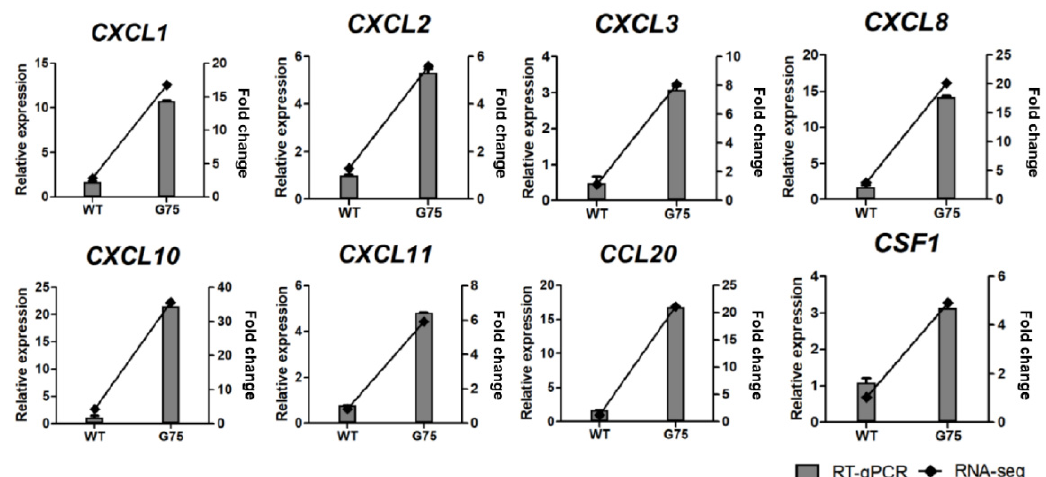
Figure 9. Real ‐ time quantitative PCR validation of RNA ‐ seq data for selected genes associated with Figure 9. Real-time quantitative PCR validation of RNA-seq data for selected genes associated with Figure 9. Real-time quantitative PCR validation of RNA-seq data for selected genes associated with NF ‐κ B signaling from Caco ‐ 2 cell. Right and left y ‐ axis represent fold change of RNA ‐ seq data and Figure 9. Real-time quantitative PCR validation of RNA-seq data for selected genes associated with NF- κ B signaling from Caco-2 cell. Right and left y -axis represent fold change of RNA-seq data and NF- κ B signaling from Caco-2 cell. Right and left y -axis represent fold change of RNA-seq data and relative expression of RT ‐ qPCR data, respectively. Relative mRNA expression was compared with NF- κ B signaling from Caco-2 cell. Right and left y -axis represent fold change of RNA-seq data and relative expression of RT-qPCR data, respectively. Relative mRNA expression was compared with relative expression of RT-qPCR data, respectively. Relative mRNA expression was compared with spore ‐ untreated control. RT ‐ qPCR analysis for mRNA expression of selected genes was normalized relative expression of RT-qPCR data, respectively. Relative mRNA expression was compared with spore-untreated control. RT-qPCR analysis for mRNA expression of selected genes was normalized spore-untreated control. RT-qPCR analysis for mRNA expression of selected genes was normalized against GAPDH . RT ‐ qPCR data are presented as mean ± standard deviation ( n = 3). spore-untreated control. RT-qPCR analysis for mRNA expression of selected genes was normalized against GAPDH . RT-qPCR data are presented as mean ± standard deviation ( n = 3). against GAPDH . RT-qPCR data are presented as mean ± standard deviation ( n = 3). against GAPDH . RT-qPCR data are presented as mean ± standard deviation ( n = 3).